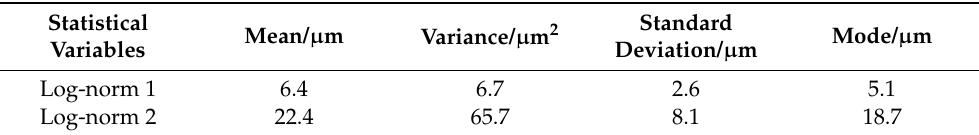
Table 3. Statistical variables for theoretical probability distribution, fitted as a bimodal lognormal